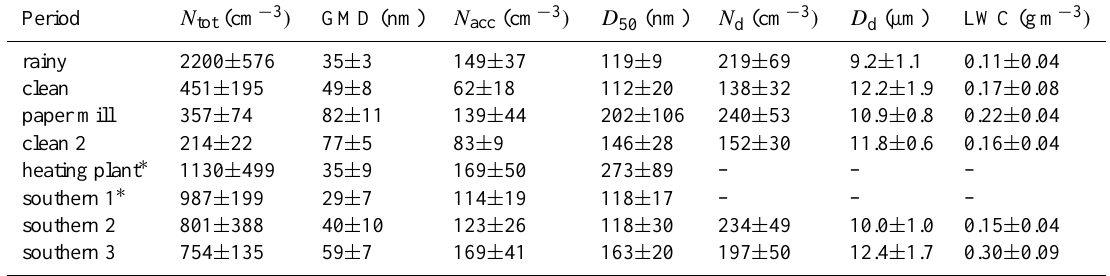
Table 6. Average values and standard deviations of total particle number concentration ( N tot ) , geometric mean particle diameter (GMD), accumulation mode particle number concentration ( N acc ) , diameter of 50% activation ( D 50 ) , cloud droplet number concentration ( N d ) , droplet diameter ( D d ) and liquid water content (LWC) for the different periods of the cloud event observed on 22–24 October 2011.